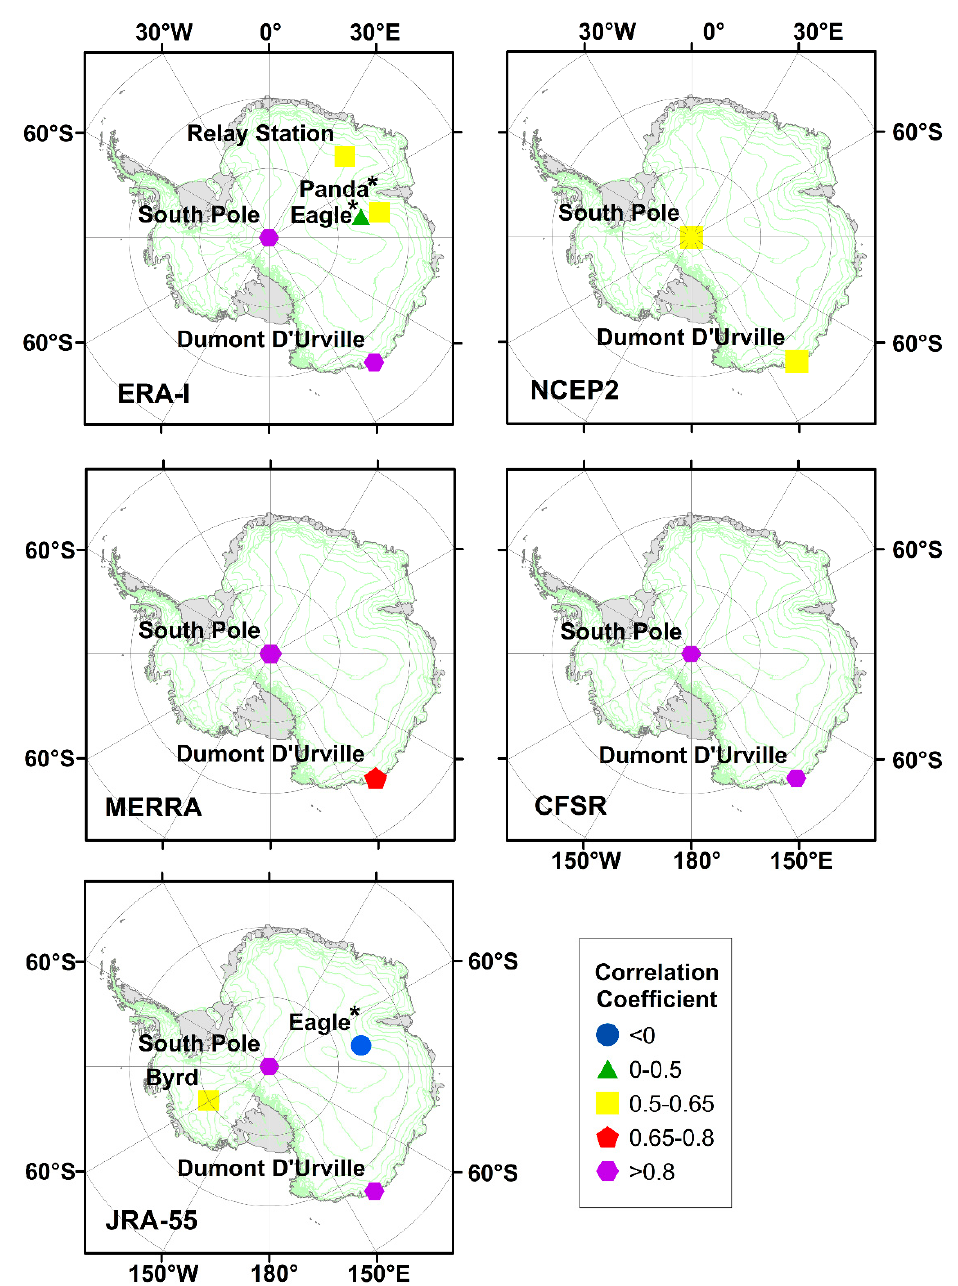
Figure 5. Maps show the seasonal correlation coefficient values at the 95% significance level. The values marked with an asterisk are at the 90% significance level. AWSs with insignificant correlations are not shown in the figure.